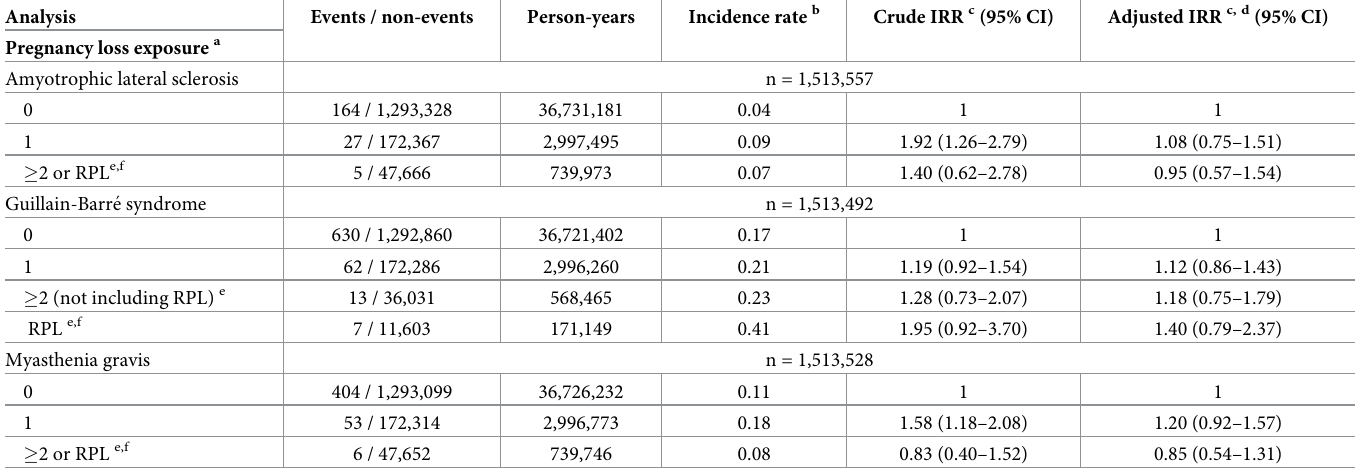
Table 3. Association of pregnancy loss with other autoimmune neurological